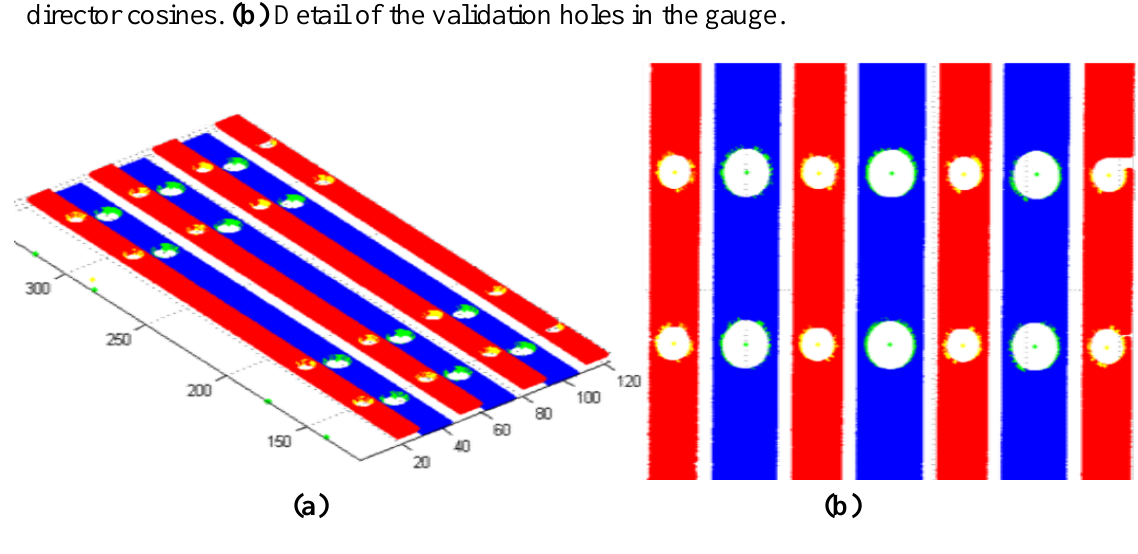
Figure 8. (a) Reconstructed cloud points from the gauge digitalization using the selected director cosines. (b) Detail of the validation holes in the